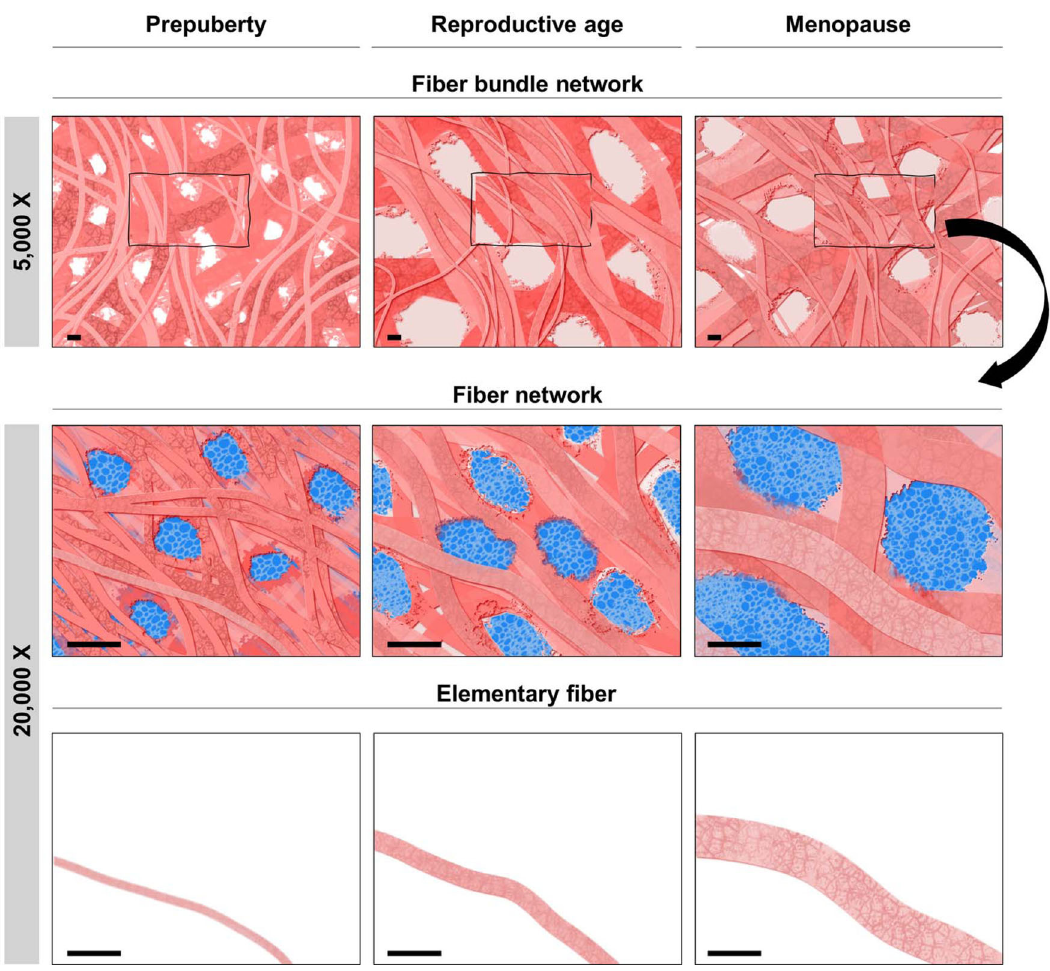
Fig. 2 Schematic illustration of fi brous ECM structure deduced from SEM image analyses. Simpli fi ed illustration of ECM structural remodeling with age at fi ber (×20,000) and fi ber bundle (×5000) scale, showing changes in fi brous network morphology (thickness, spacing). Scale: 1 µ m.